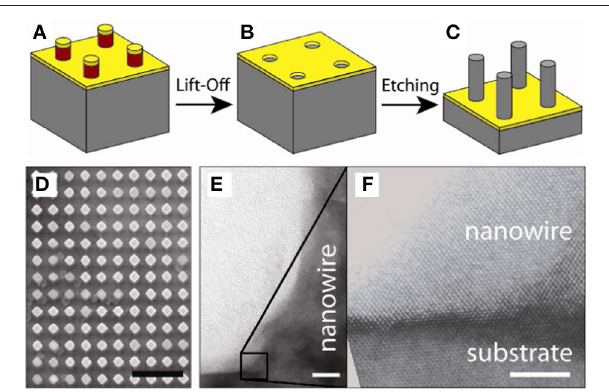
FIGURE 11 | Metal-assisted chemical etching. (A) Metal evaporation, (B) lift-off, and (C) vertical Si NWs array by metal-assisted etchinG, (D) nanowires with diameter about 350nm, (E) highlighted the root of NWs and the substrate by TEM, and (F) magnified NWs and substrate. Reprint from de Boor et al. (2010) with